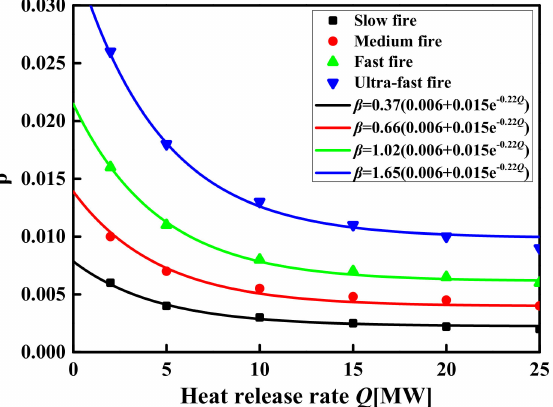
Figure 17. The β value changes with the HRR under different fire growth